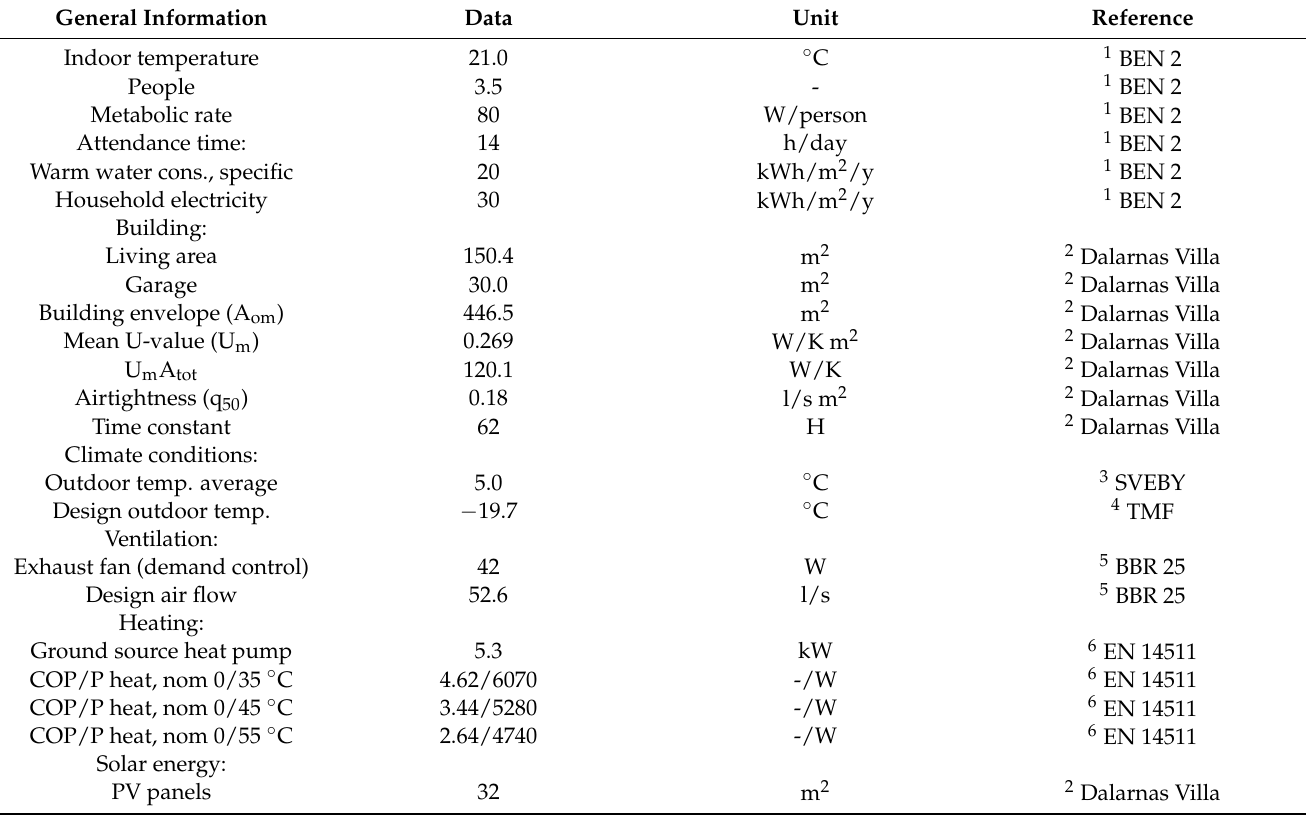
Table 4. Input data on building, climate conditions and energy; adapted